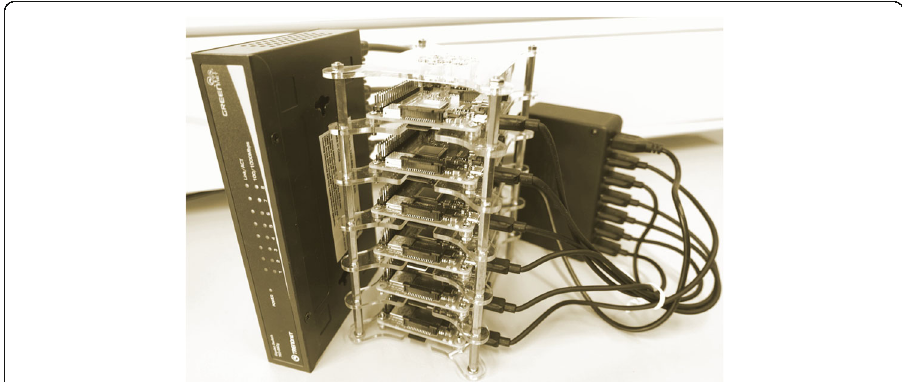
Fig. 4 The cluster of Raspberry Pi embedded systems realizing a decentralized CHIL